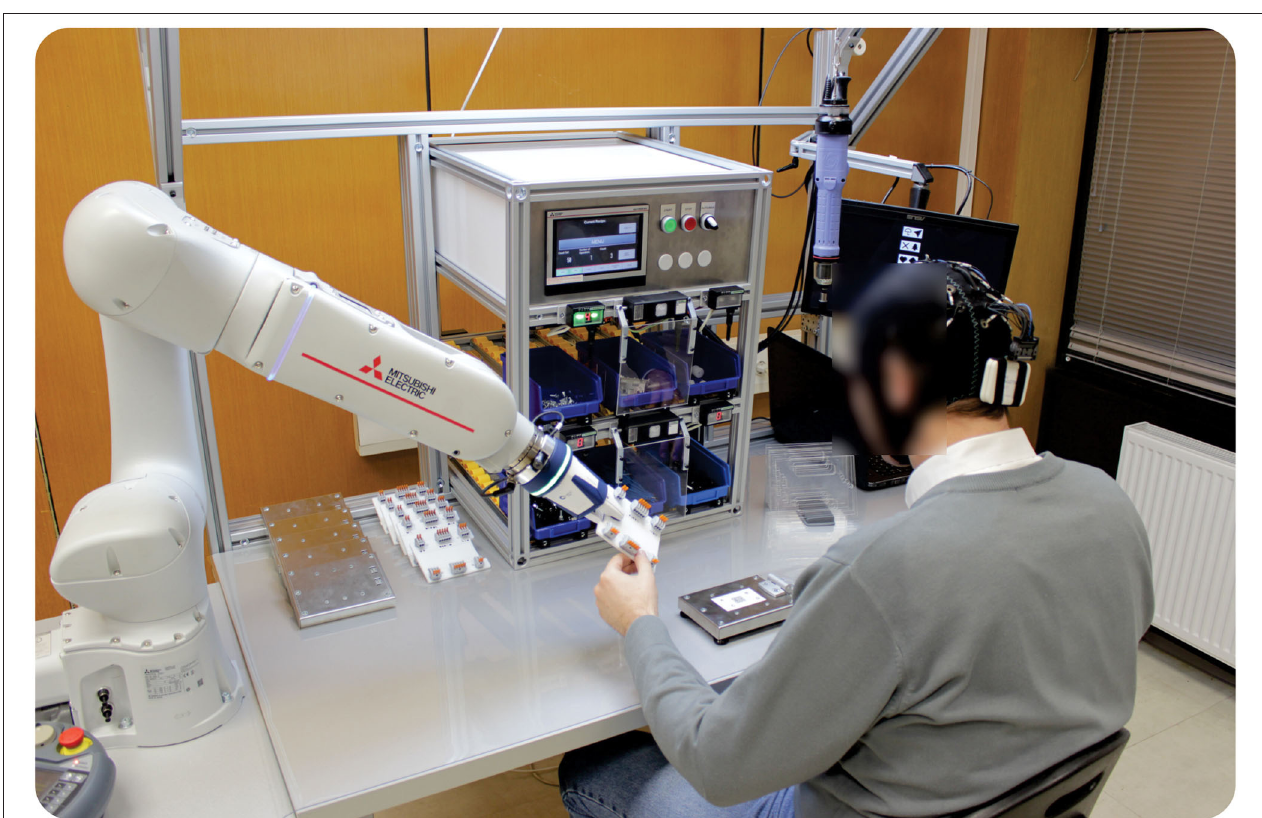
FIGURE 5 | The workplace of the